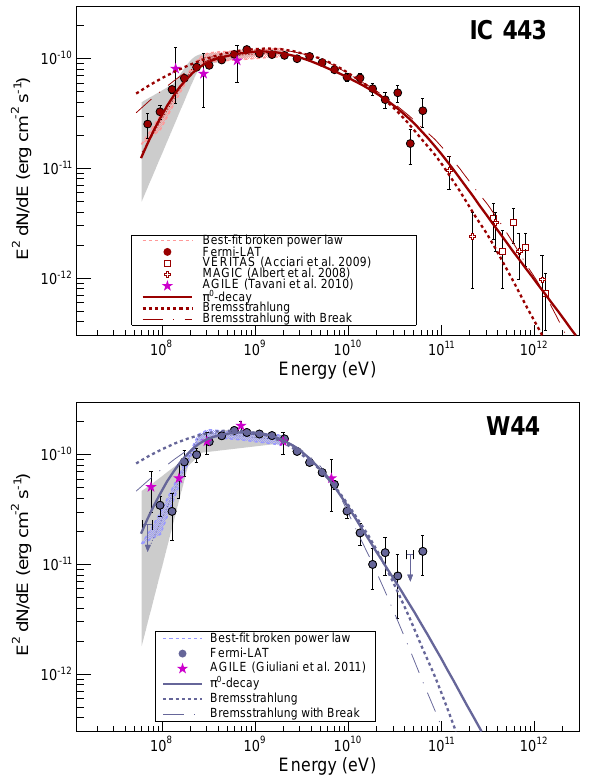
Figure 5: (A and B) Gamma-ray spectra of IC 443 (A) and W44 (B) as measured with the Fermi -LAT [37] . Color-shaded areas bound by dashed lines denote the best-fit broadband smooth broken power law (60 MeV to 2 GeV), gray-shaded bands show systematic errors below 2 GeV due mainly to imperfect modeling of the galactic diffuse emission. At the high-energy end, TeV spectral data points for IC 443 from MAGIC [38] and VERITAS [39] are shown. Solid lines denote the best-fit pion-decay gamma-ray spectra, dashed lines denote the best-fit bremsstrahlung spectra, and dash-dotted lines denote the best-fit bremsstrahlung spectra when includ- ing an ad hoc low-energy break at 300 MeV c − 1 in the electron spectrum. These fits were done to the Fermi LAT data alone (not taking the TeV data points into account). Magenta stars denote measurements from the AGILE satellite for these two SNRs, taken from [40] and [41], respectively.